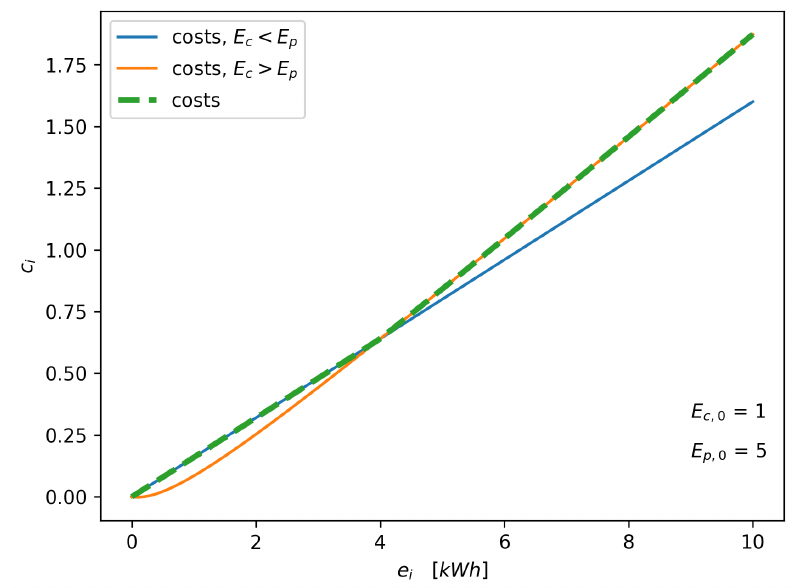
Figure 5. Buying cost (in green) as a composition of the two sub-cases in which the EC is a net energy importer (orange) or net energy exporter (blue). The shape of the lines depend on the fixed values of E c ,0 and E p ,0 , but the final expression is always